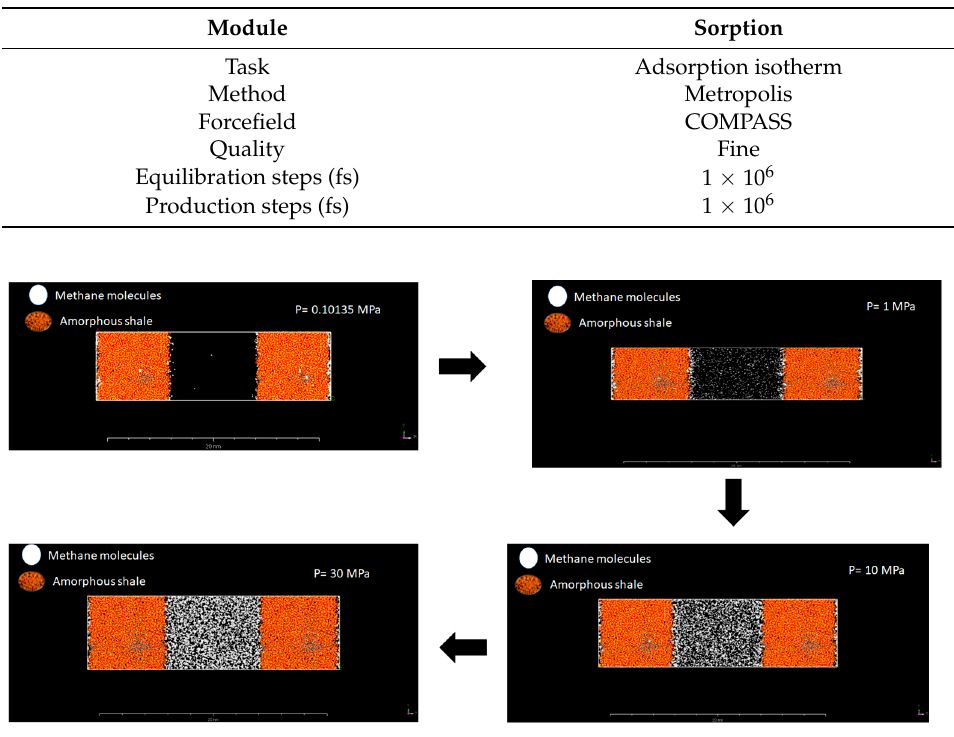
Figure 7. Snapshots of the methane adsorption in shale microporous structure at T = 90 ° C (363.15 K).